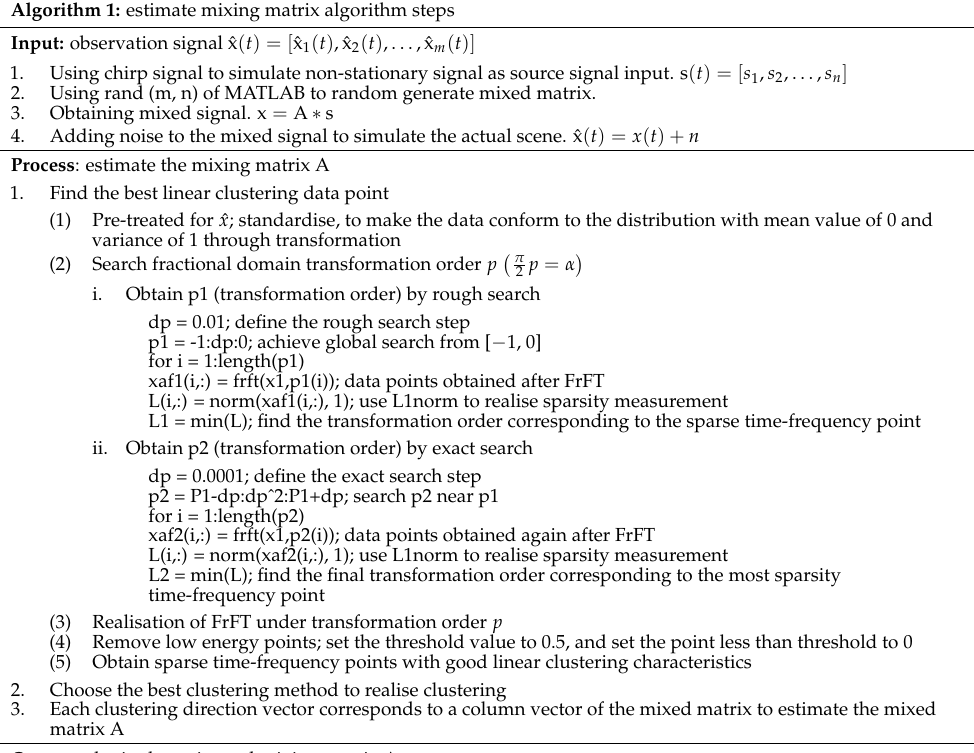
Algorithm 1: estimate mixing matrix algorithm